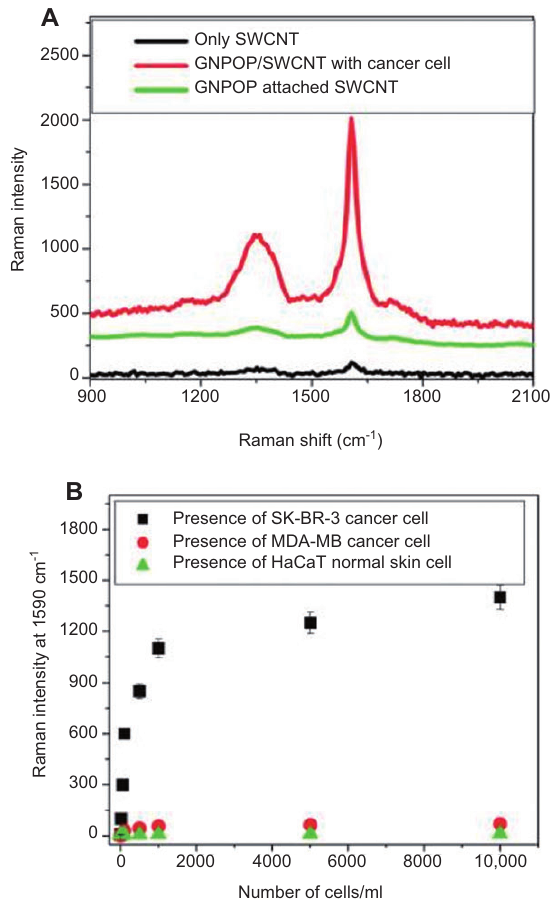
Figure 3 (A) SERS spectra of the hybrid nanosystem SK-BR-3 breast cancer cells (10 4 cells ml -1 ). (B) SERS intensity changes at 1590 cm -1 for increased concentrations of cells (SK-BR-3 and MDA-MB human breast cancerous, and HaCaT normal skin cells). Reproduced with permission from: Beqa et al. (2011) . Copyright 2011, American Chemical